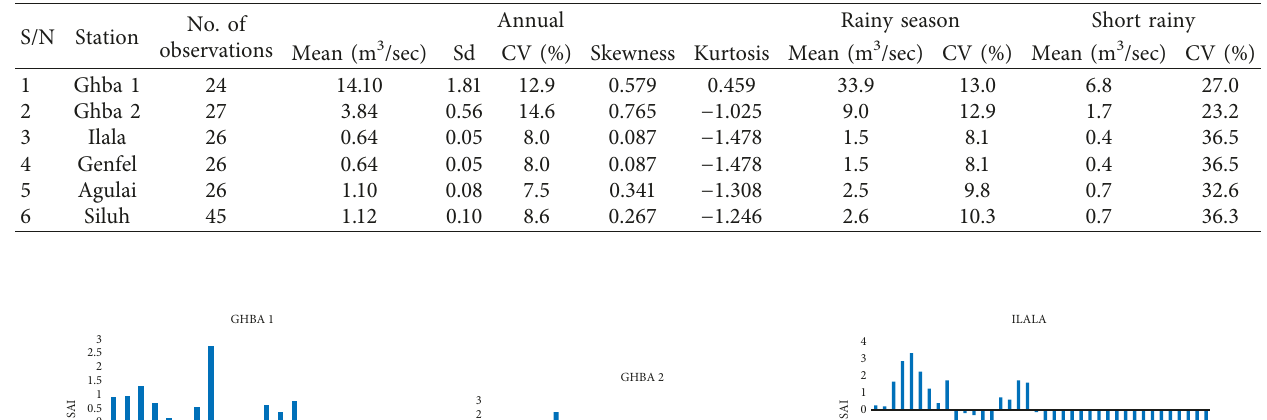
Table 3: Summary of descriptive statistical analysis of streamflow stations.